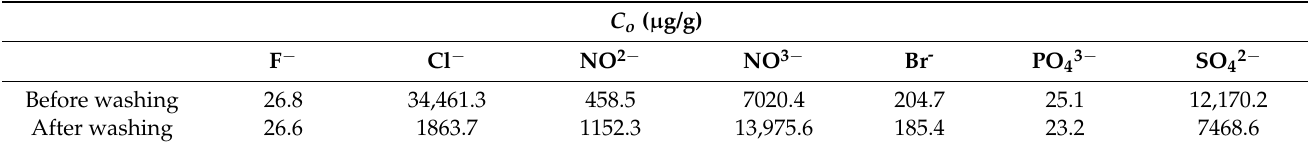
Table 3. Values of C o for each halogen emitted during